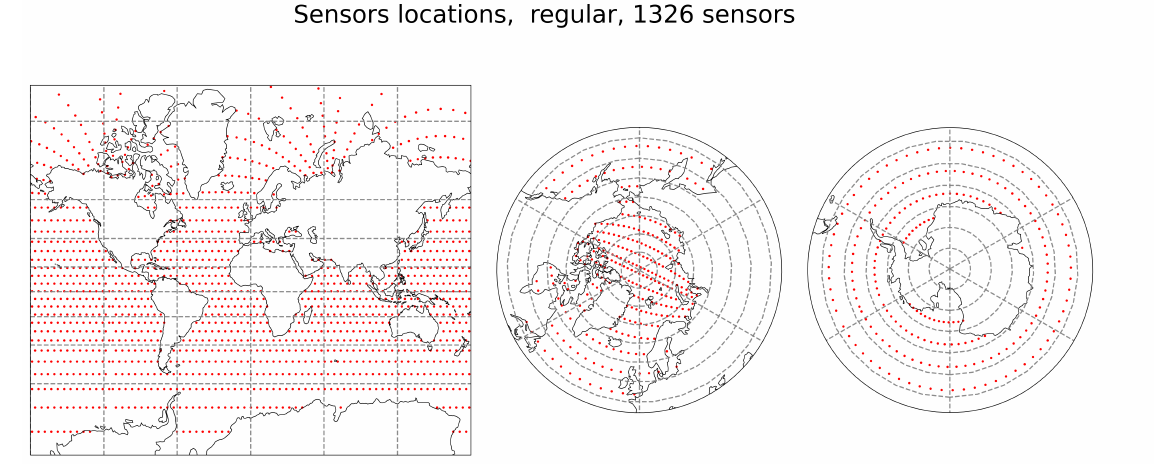
Figure 6. Locations of the 1326 sensors regularly